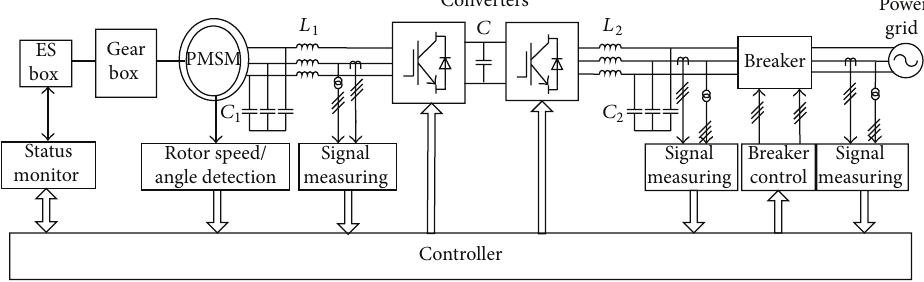
Figure 1: The composition scheme of MEES system served by PMSM and bidirectional converters.